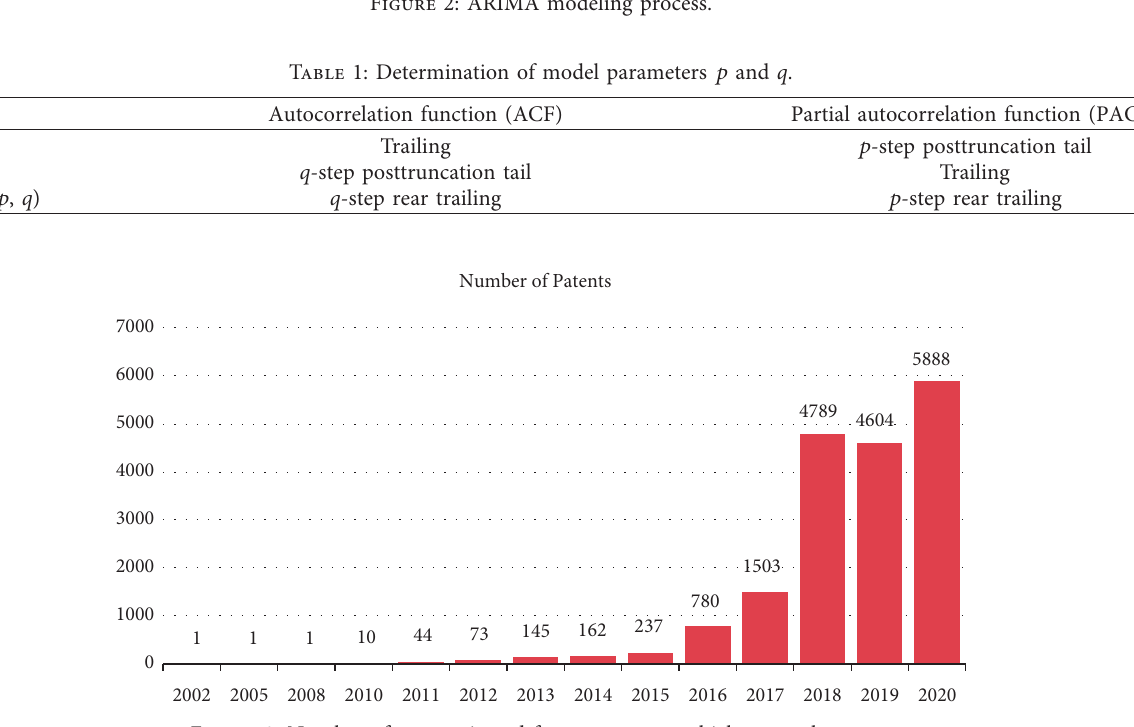
Figure 3: Number of patents issued for new energy vehicles over the